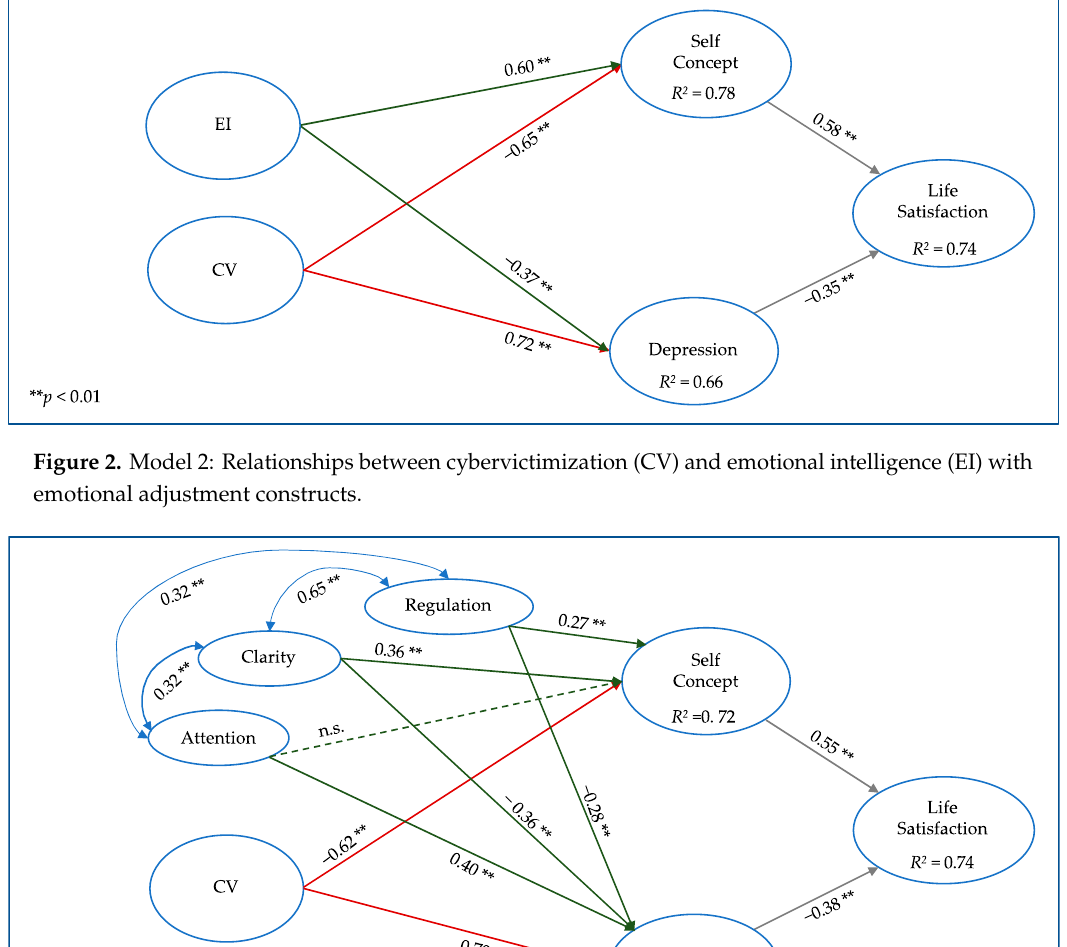
Figure 2. Model 2: Relationships between cybervictimization (CV) and emotional intelligence (EI) with emotional adjustment constructs.